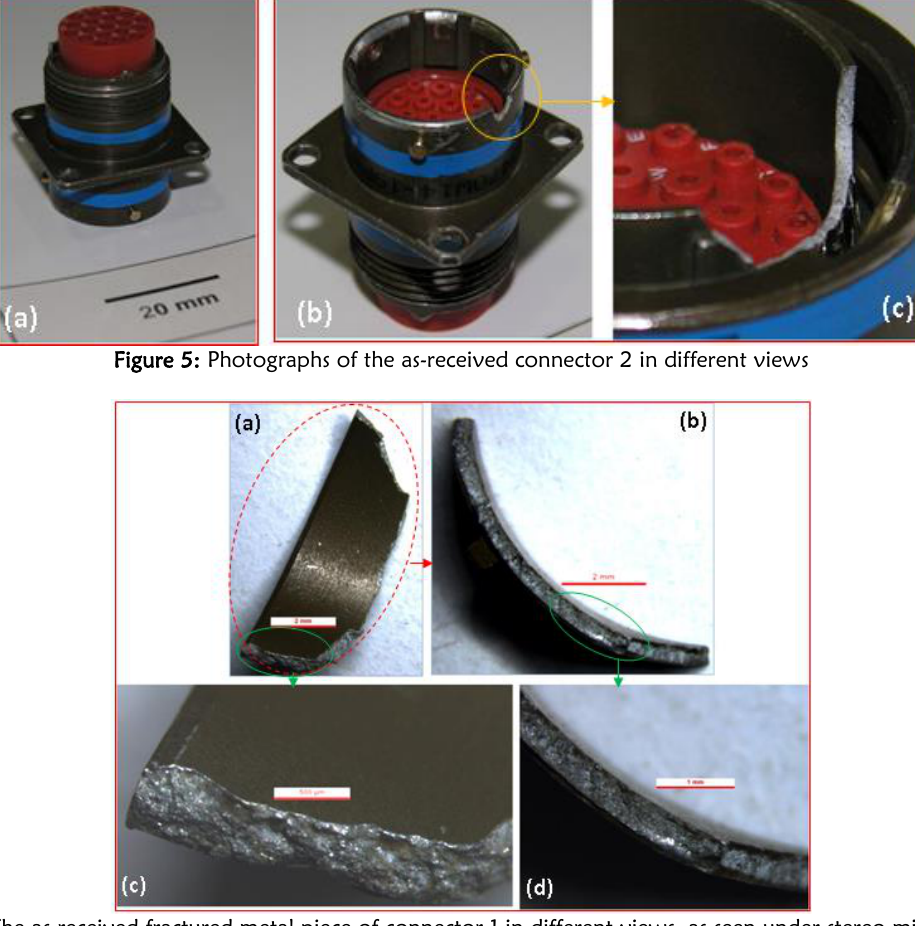
Figure 6: The as-received fractured metal piece of connector 1 in different views, as seen under stereo microscope